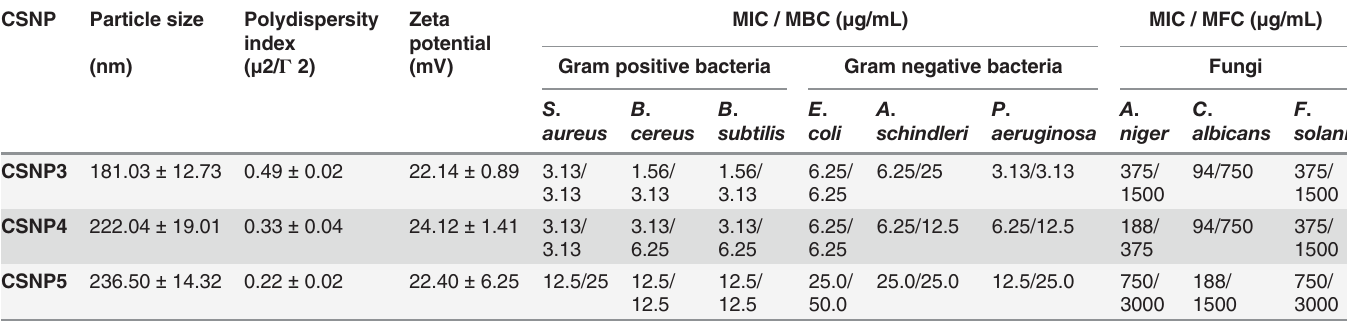
Table 2. Particle size, polydispersity, zeta potential, antibacterial and antifungal activities of CSNP3, CSNP4 and CSNP5.(n = 3). CSNP Particle